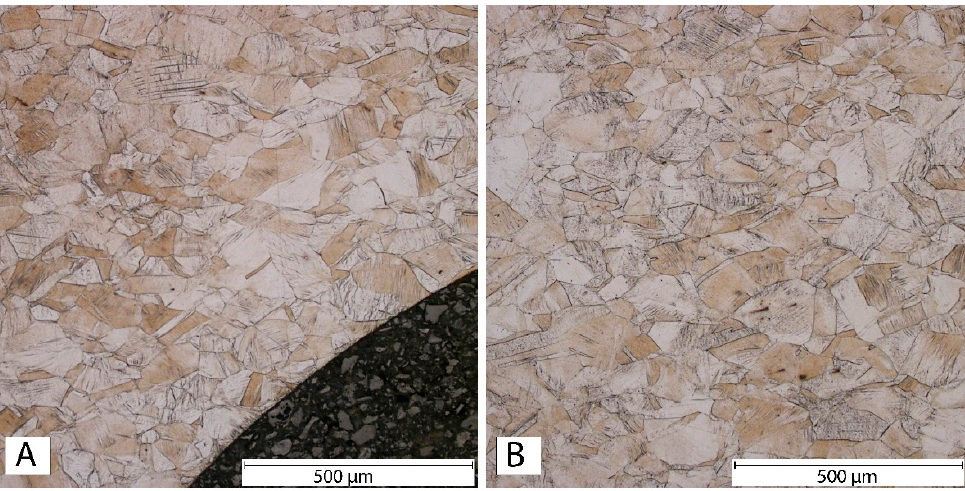
Figure 2. ( A ) Microstructure of material near the threaded hole, ( B ) microstructure of bulk material.